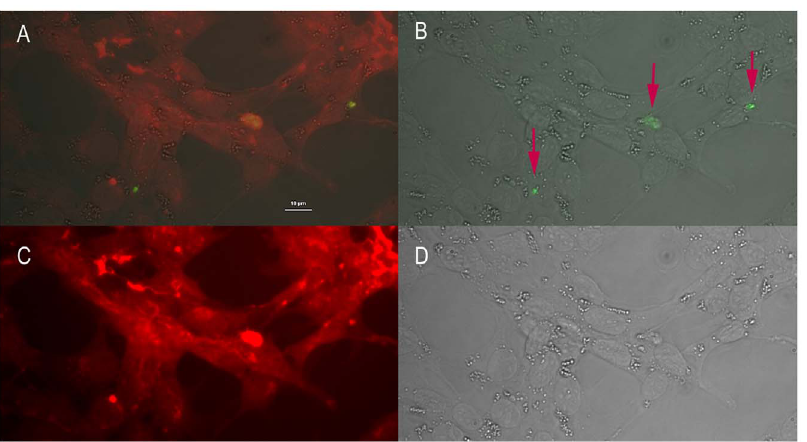
Figure 2. c -synuclein ab uptake of RGC-5 revealed by indirect immunfluorescence. Living cells were preincubated 3 h with sheep polyclonal anti c -synuclein abs and then fixed, permeabilized, blocked and stained with rabbit anti sheep IgG-H&L conjugated with FITC. Cell membrane was stained with wheat germ agglutinin conjugated with Rhodamin. A : Bright light merged with corresponding fluorescence and cell membrane staining microscopy. B : Corresponding fluorescence micrograph merged with bright light. C : Cell membrane microscopy. D : Bright light microscopy